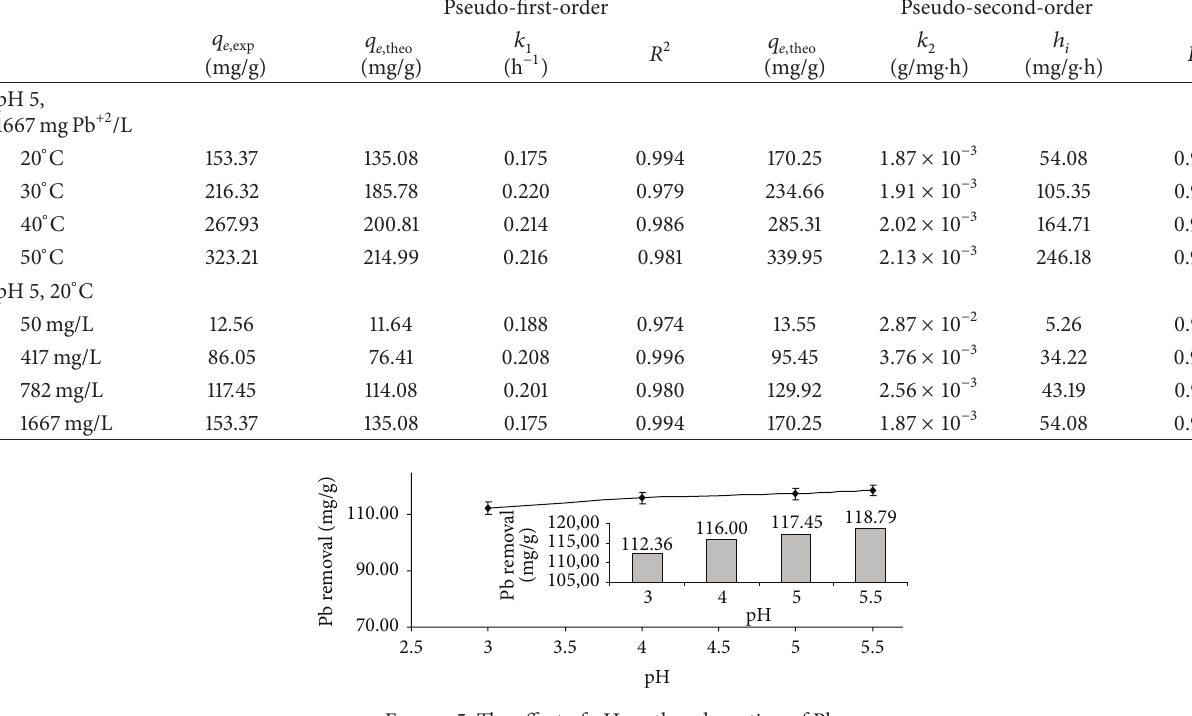
Figure 5: The effect of pH on the adsorption of Pb.